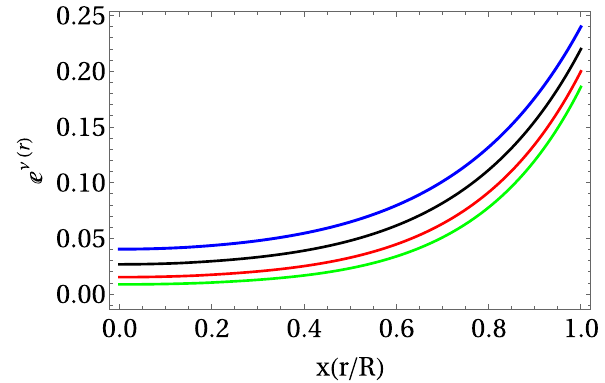
Fig. 7 Temporal metric for Model II for compact factors: 0.38 (blue line), 0.39 (black line), 0.40 (red line) and 0.407 (green line)